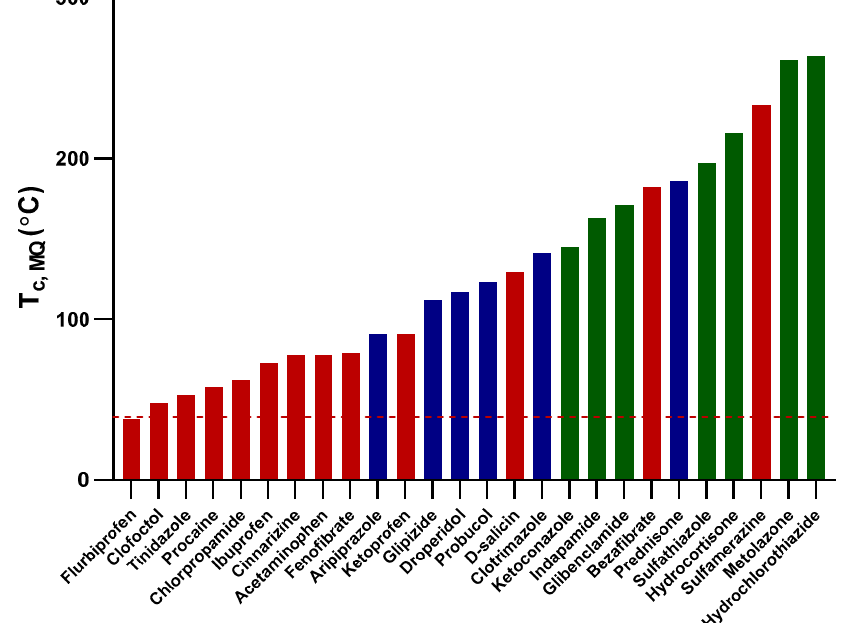
Figure 4. A bar chart demonstrating the crystallization temperatures of melt-quenched (T c, MQ ) of the study compounds in relation to the average spray-drying outlet temperature (red dashed-line; 39 °C). The solid-state forms of the compounds on spray-drying are represented by different colors: red represents fully crystalline, blue represents a mixture of amorphous and crystalline, and green represents fully amorphous compounds.